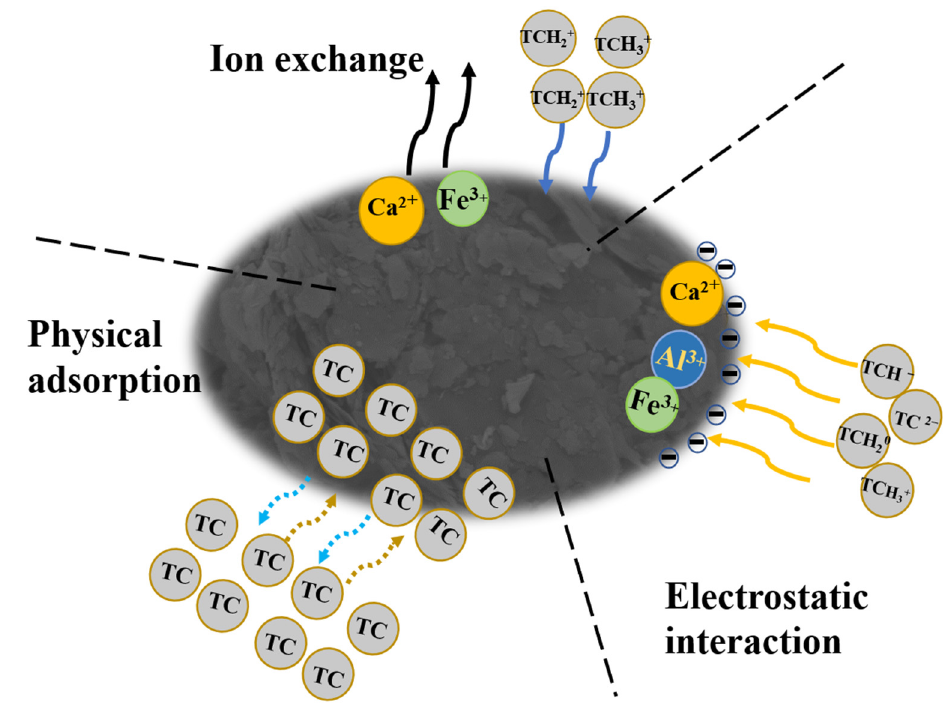
Figure 8 . The proposed adsorption mechanism of TC adsorption by CG . Figure 8. The proposed adsorption mechanism of TC adsorption by CG. Additionally, the adsorption kinetic analyses confirmed that the adsorption of TC by CG was affected by the chemical adsorption process. Considering that the TC was an am- photeric molecule [46], the TC would occur in the protonation and deprotonation reac- tions at varying pH conditions. At a pH lower than pK a1 (3.3), the TC was dominant with species of TCH 3+ . With the pH ranging between pK a1 and pK a2 (3.3 < pH < 7.7), the TC was mainly presented with TCH 2+ . At pH further increasing to a range of (7.7 < pH < 9.7) and (pH > 9.7), the dominant species of TC were TCH − and TC 2 − , respectively [47]. The species of TCH 3+ and TCH 2+ in acidic and neutral environments would be exchanged with the positively charged ions (Ca 2+ , Fe 3+ ) in CG. Additionally, the concentrations of Fe and Ca were determined as 140.8 μ g/L and 173.2 μ g/L, respectively, further confirming the metal